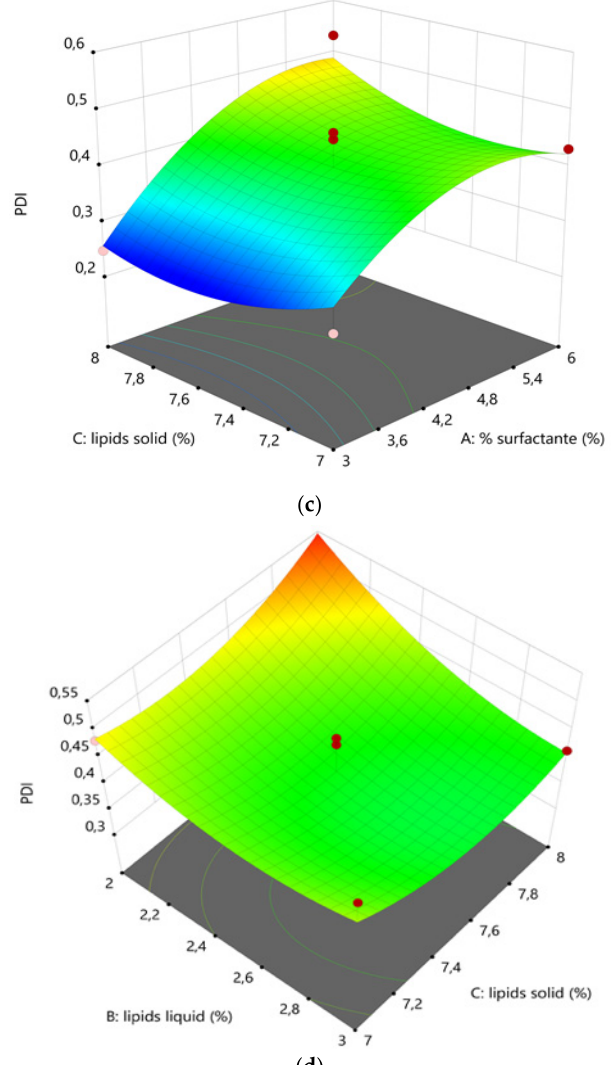
Figure 2. Pareto chart ( a ) and three-dimensional response surface plots showing the effect of ( b ) the concentration of liquid lipid and surfactant, ( c ) the concentration of surfactant and solid lipid and ( d ) the concentration of liquid lipid and solid lipid on NLC polydispersity index (PDI), respectively.